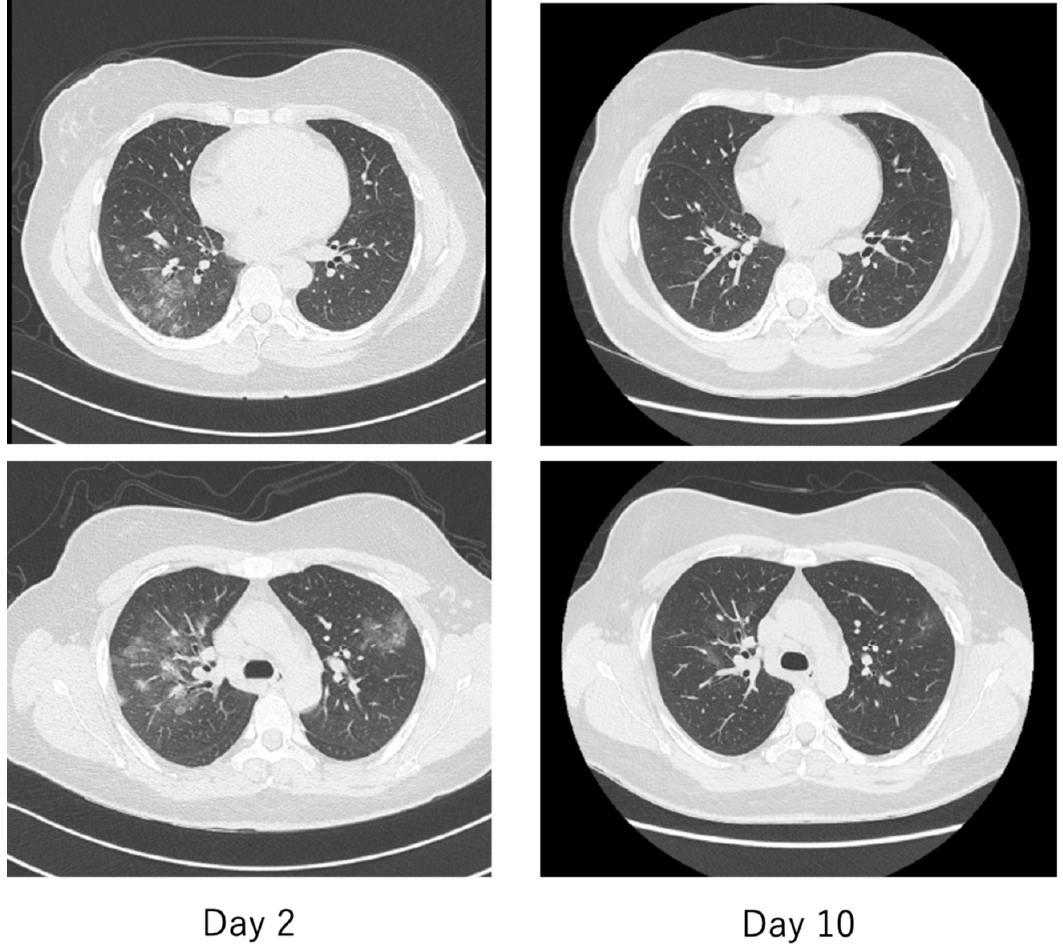
Figure 13. Chest computed tomography (CT) of a patient with mild COVID-19, the same patient as in Figure 12. On the second day, there were multiple faint frosted shadows bilaterally ( left ), but by the tenth day, the abnormal shadows had almost disappeared ( right ).